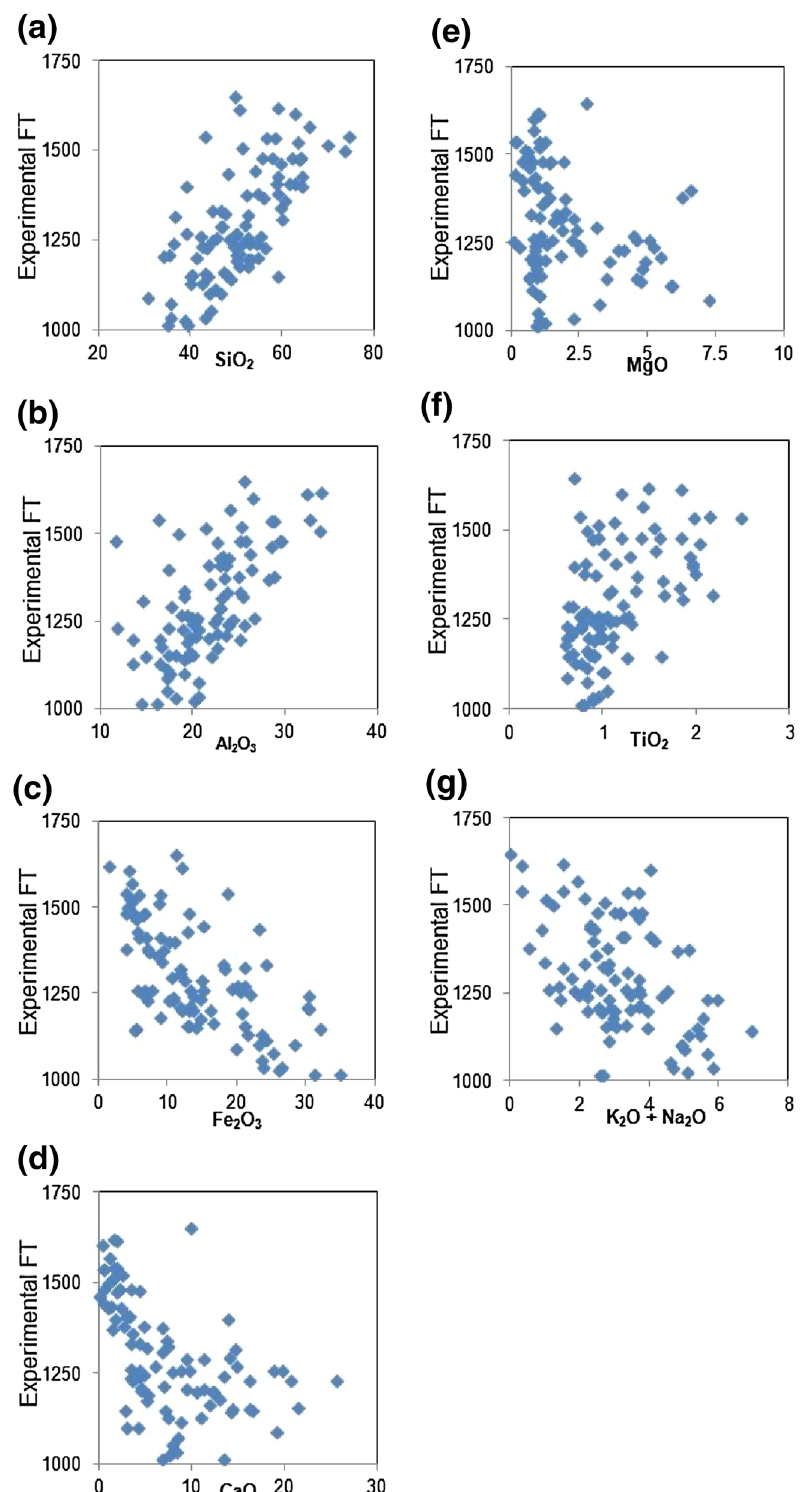
Fig. 4 Cross-plots of weight percentages (wt%) of individual metal oxides versus FT